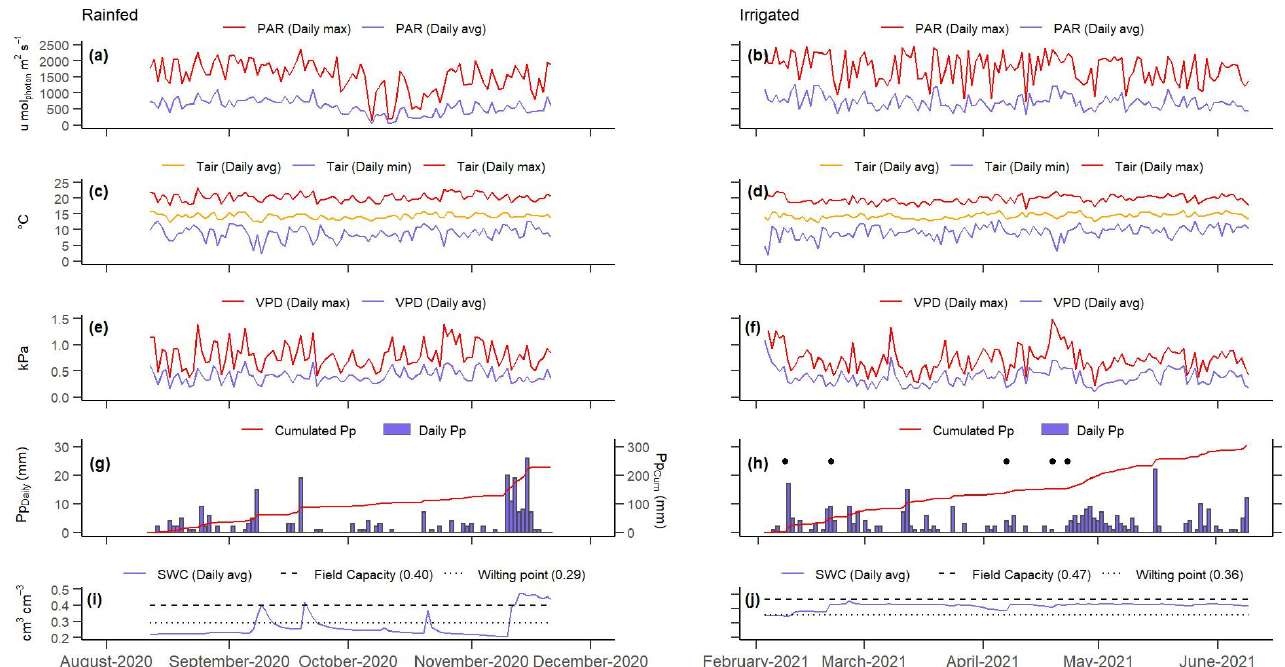
Figure 1. Meteorological measurements for Rainfed (12 August–22 November 2020) and Irrigated (3 February–9 June 2021). ( a , b ) photosynthetic active radiation, µmol photons m − 2 s − 1 (PAR); ( c , d ) air temperature, °C (Tair); ( e , f ) vapor pressure deficit, kPa (VPD); ( i , j ) soil water content, cm 3 cm − 3 (SWC), measured at 0–20 cm depth, are shown as daily mean values; ( g , h ) daily and cumulated precipitation, mm (Pp), is shown as daily sum, black dots indicate irrigation times.